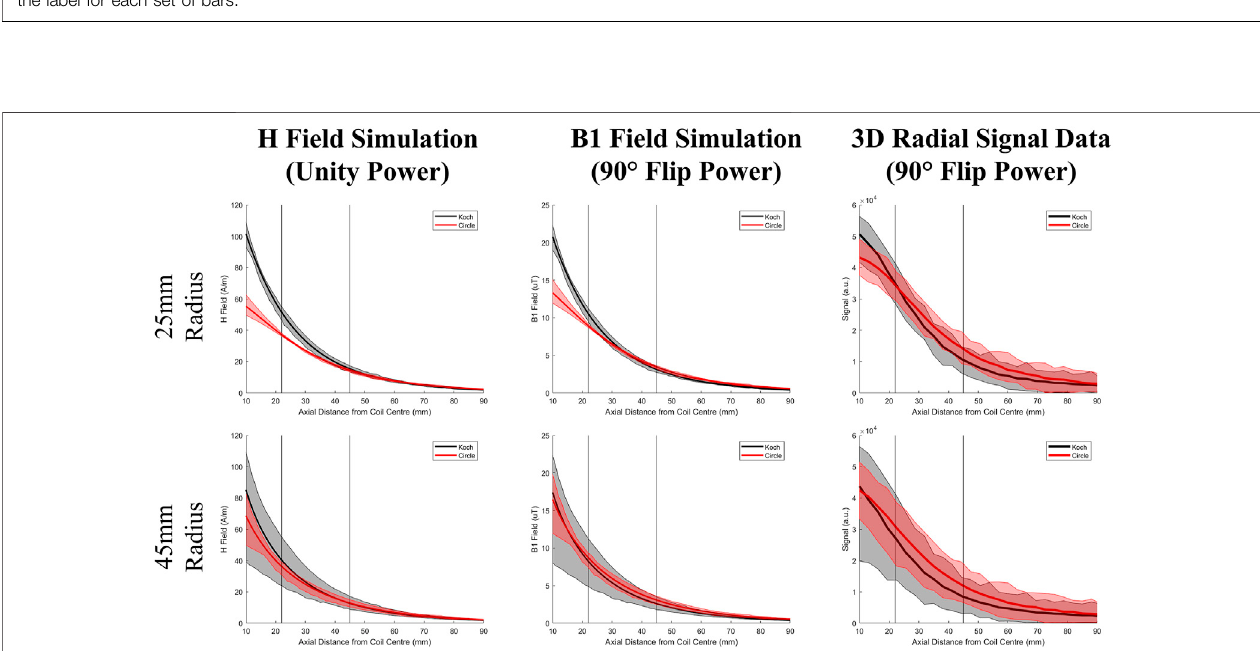
FIGURE7| Theplotsof fi eldstrengthandvariationofthesimulatedH fi eld(giveninA/m),thepowercompensatedsimulated B 1 fi eld(givenin μ T),andthemeasured signalfromthe3Dradialvolumedata(givenina.u.)overacircularROI(ofradii25and45 mm)astheROImovesawayfromthecoilanddeeper intothephantomforboth the circular and fractal coils. The mean of the fi eld strength is given by the bold curves in red and black, and the lighter bands in grey and pink that encompass the bold curves represent the range of signal values over the ROI at each distance from the coil.